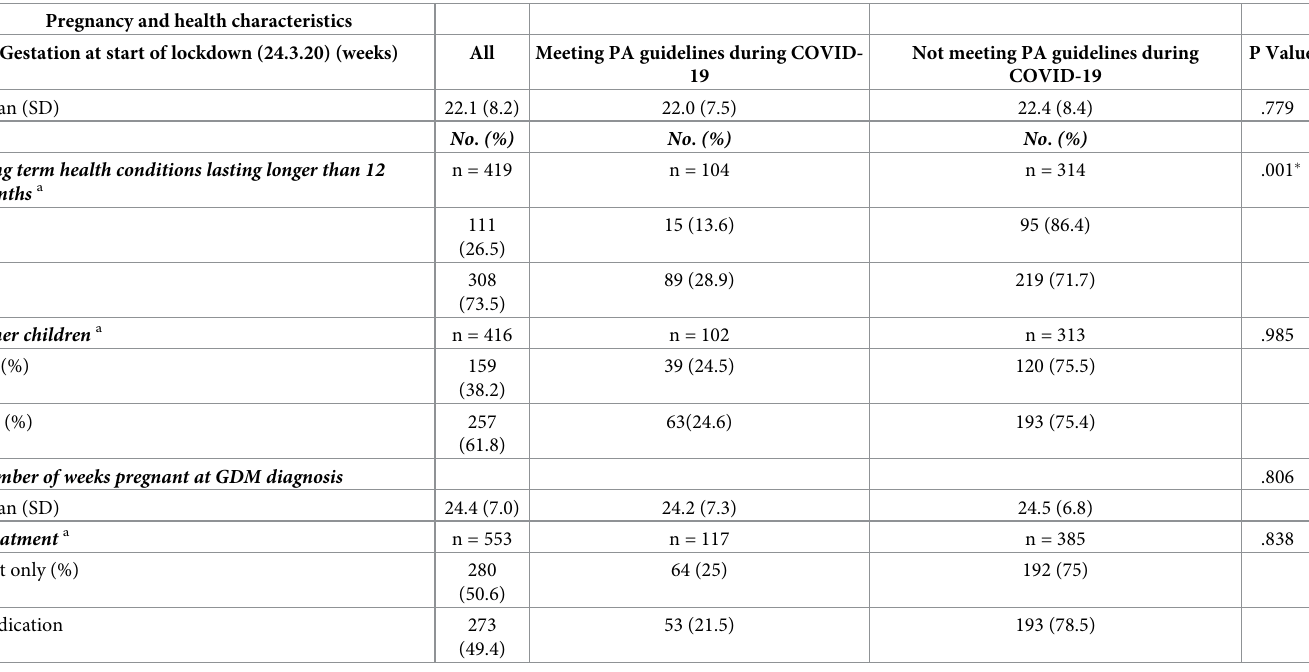
Table 2. Pregnancy and health characteristics of respondents from online survey for pregnant women with GDM during COVID-19 pandemic according to meeting the physical activity guidelines/not meeting physical activity guidelines. Pregnancy and health